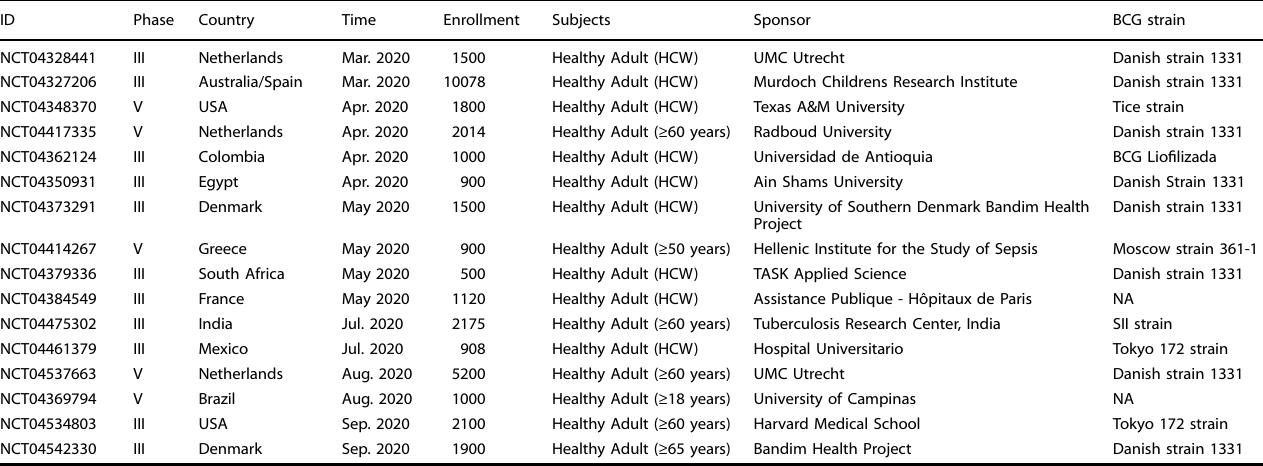
Table 2. Ongoing clinical trials of BCG as a mitigation factor against COVID-19.